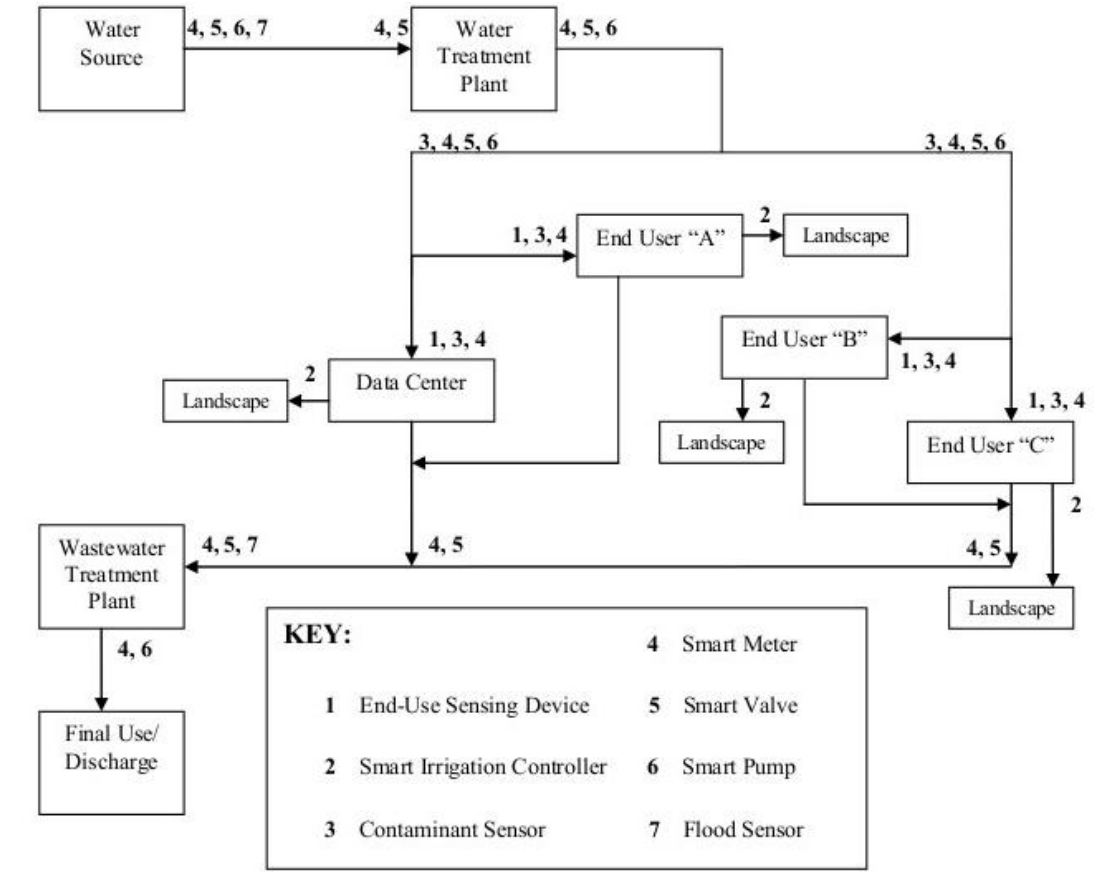
Figure 1. A simplified diagram of an example urban smart water